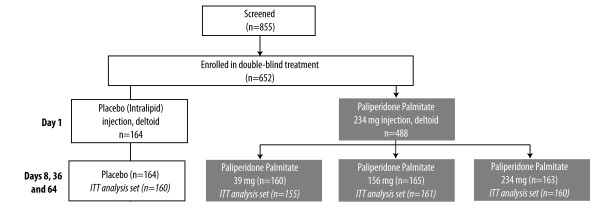
Subject Randomization. Of 652 subjects enrolled in the double-blind treatment period, 488 were randomized (1:1:1:1) to paliperidone palmitate (fixed dose of 39, 156, or 234 mg) and 164 to placebo. All those randomized to the fixed doses of paliperidone palmitate received 234 mg as the first initiation dose on Day 1, followed by administration of their fixed dose on Days 8, 36, and 64.